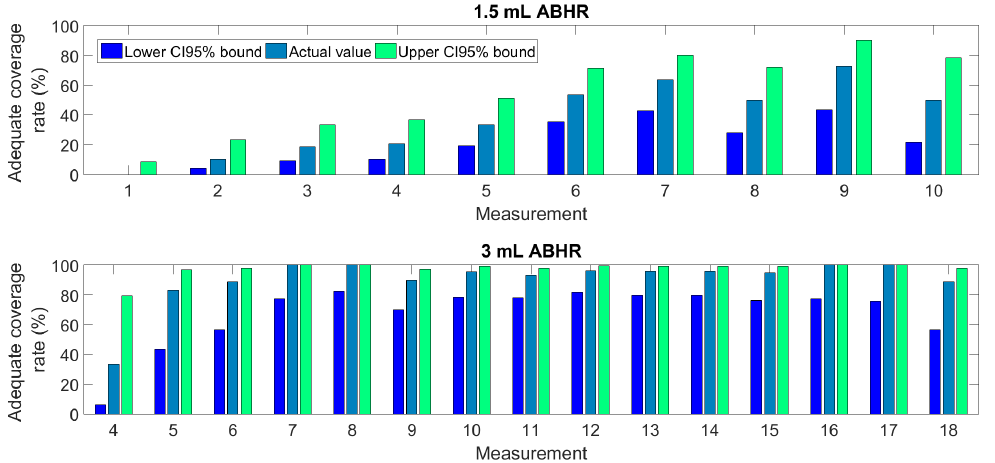
Figure 3. The rate of adequate coverage (with CI 95% values) of all participants at various measure- ments using 1.5 mL and 3 mL